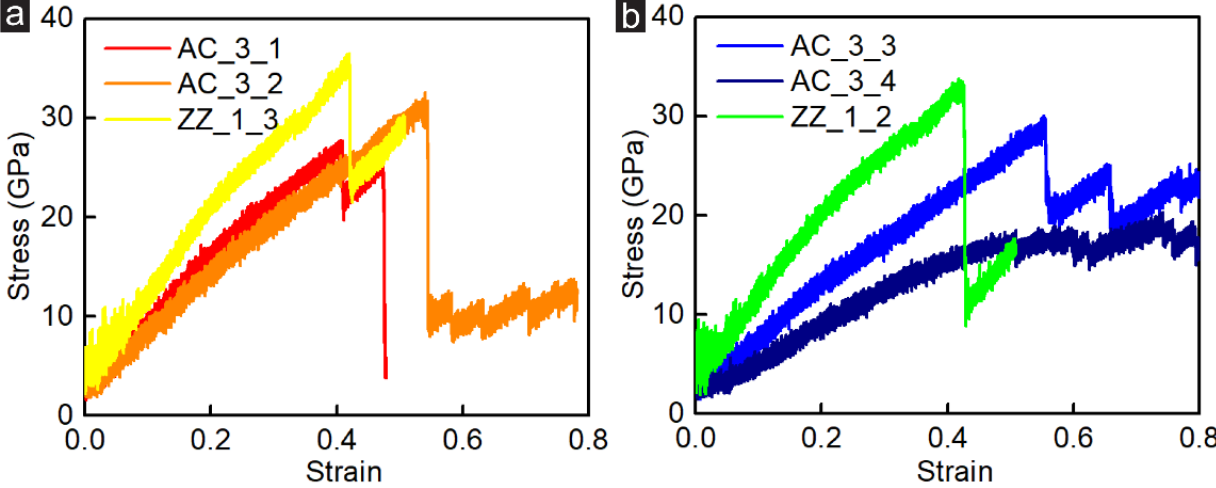
Figure 6. The stress-strain curves of ( a ) Samples AC_3_1, AC_3_2 and ZZ_1_3 and ( b ) Samples AC_3_3, AC_3_4 and ZZ_1_2 under shear loading simulation.